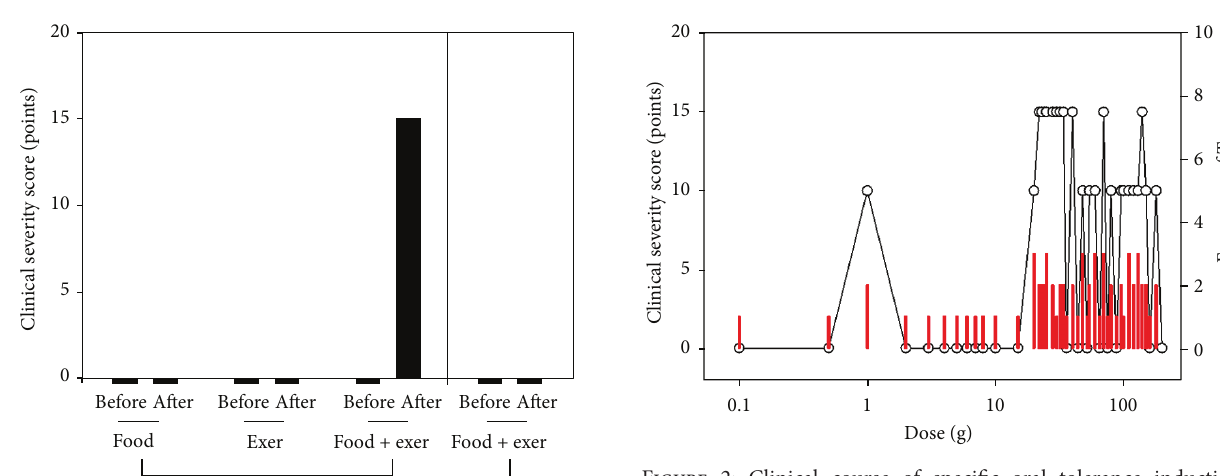
Figure 2: Clinical course of specific oral tolerance induction (SOTI) using IFN-gamma for food-dependent exercise-induced anaphylaxis (FDEIA) (Case 1). Solid line with spot is the change of clinical severity scores according to the dose. Bars are the frequency of treatment at the same dose to which patients showed allergy provocation by SOTI using IFN-gamma until overcoming the allergy provocation and resultant tolerance to the